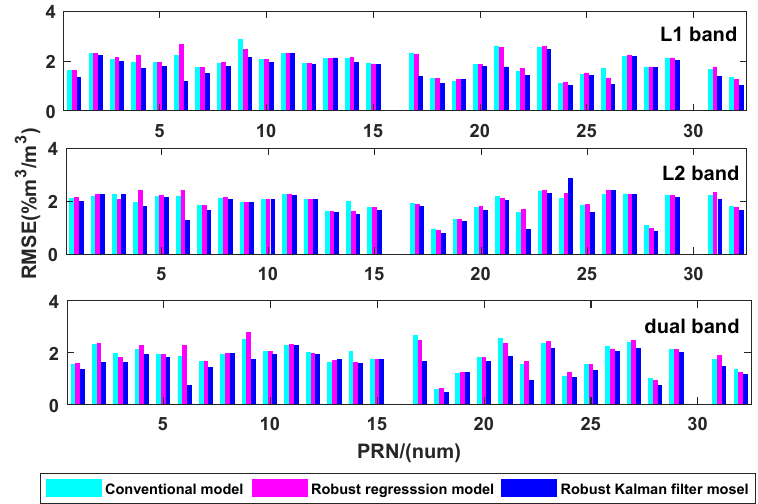
Figure 13. RMSE of three methods on each frequency with amplitude.